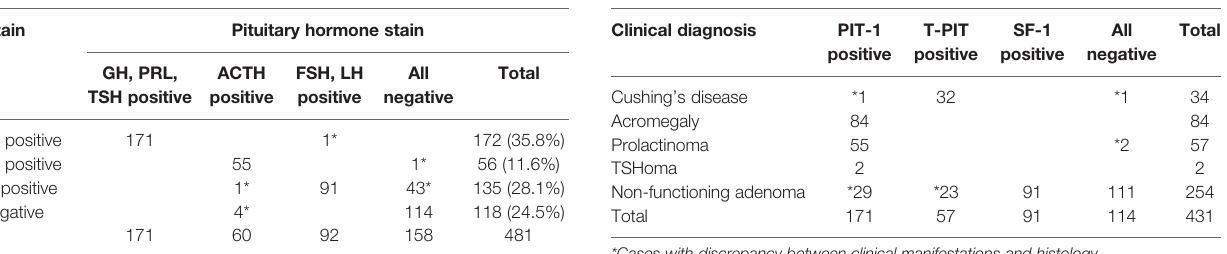
TABLE 4 | Comparison between clinical manifestations and histology for 431 patients with concordant immunohistochemical stains for TFs and pituitary